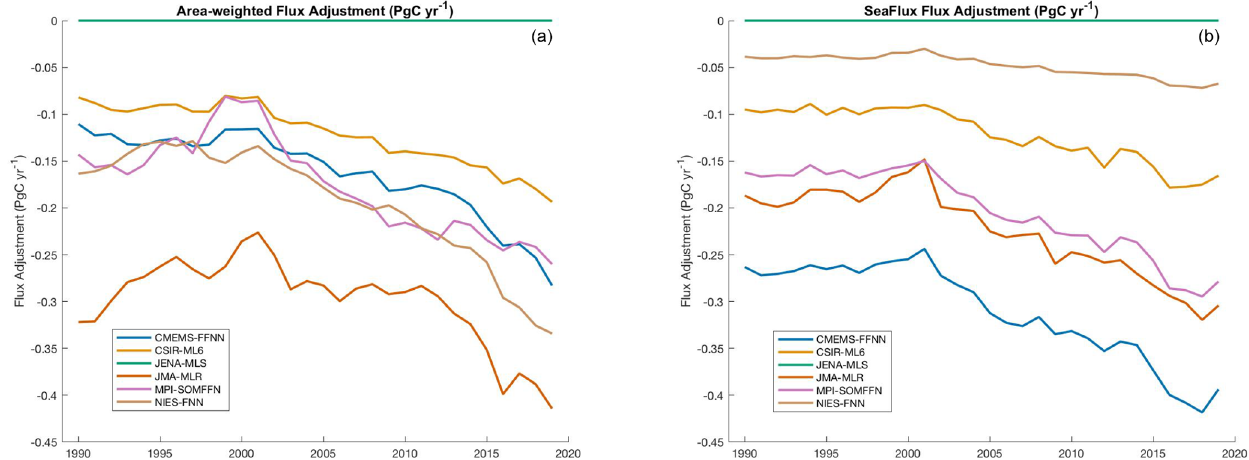
Figure A2. Annual time series of the additional flux amount calculated by the area-weighted method used in the Global Carbon Budget (a) and a similar plot showing the annual additional flux using the SeaFlux methodology (b) .